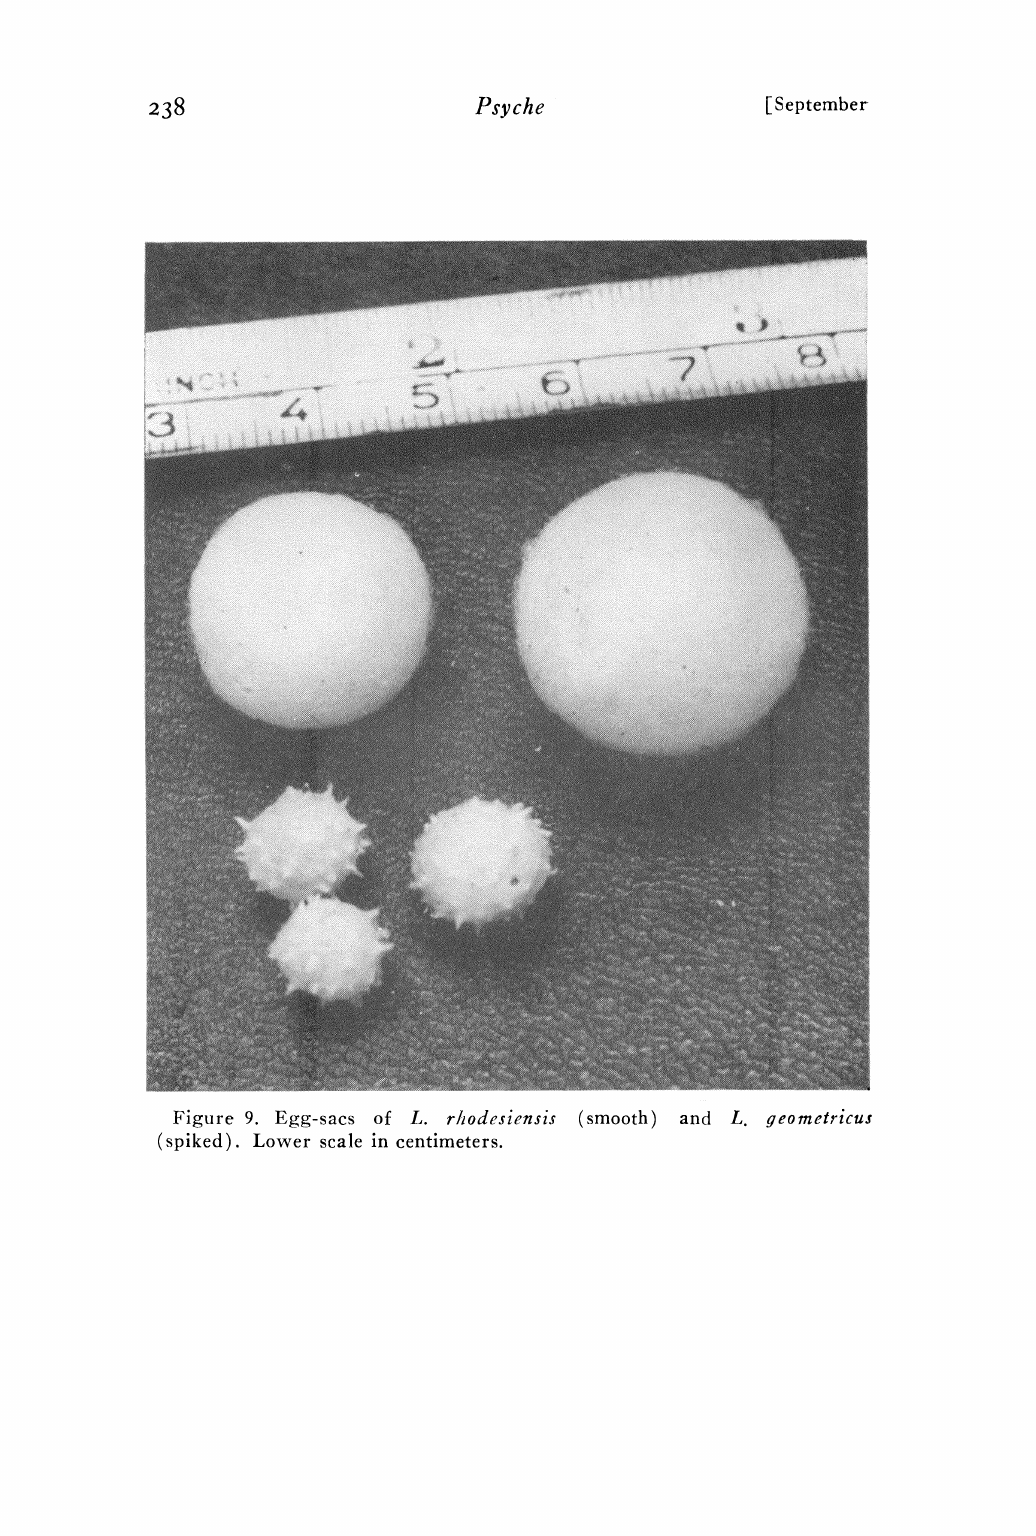
Figure 9. Egg-sacs of L. rhodesiensis (smooth) and L. geometricus (spiked). Lower scale in